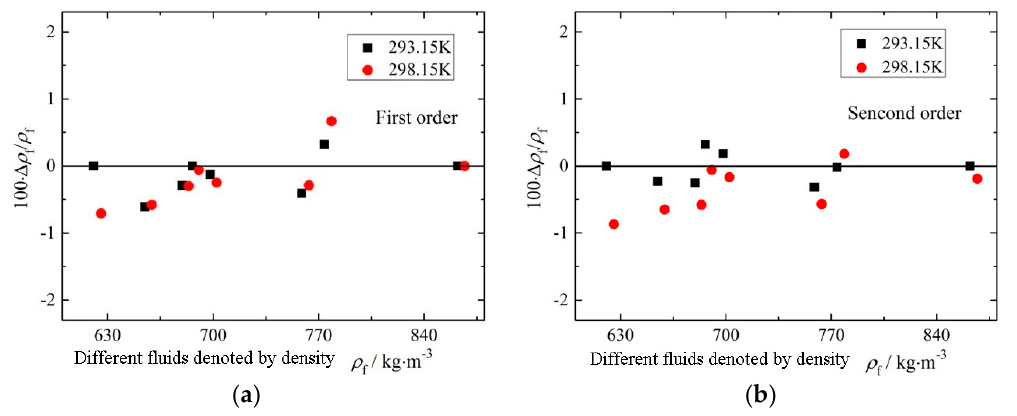
Figure 11. Relative errors of density under different order modes. ( a ) Under first order mode (flexure); ( b ) under second order mode (torsion).